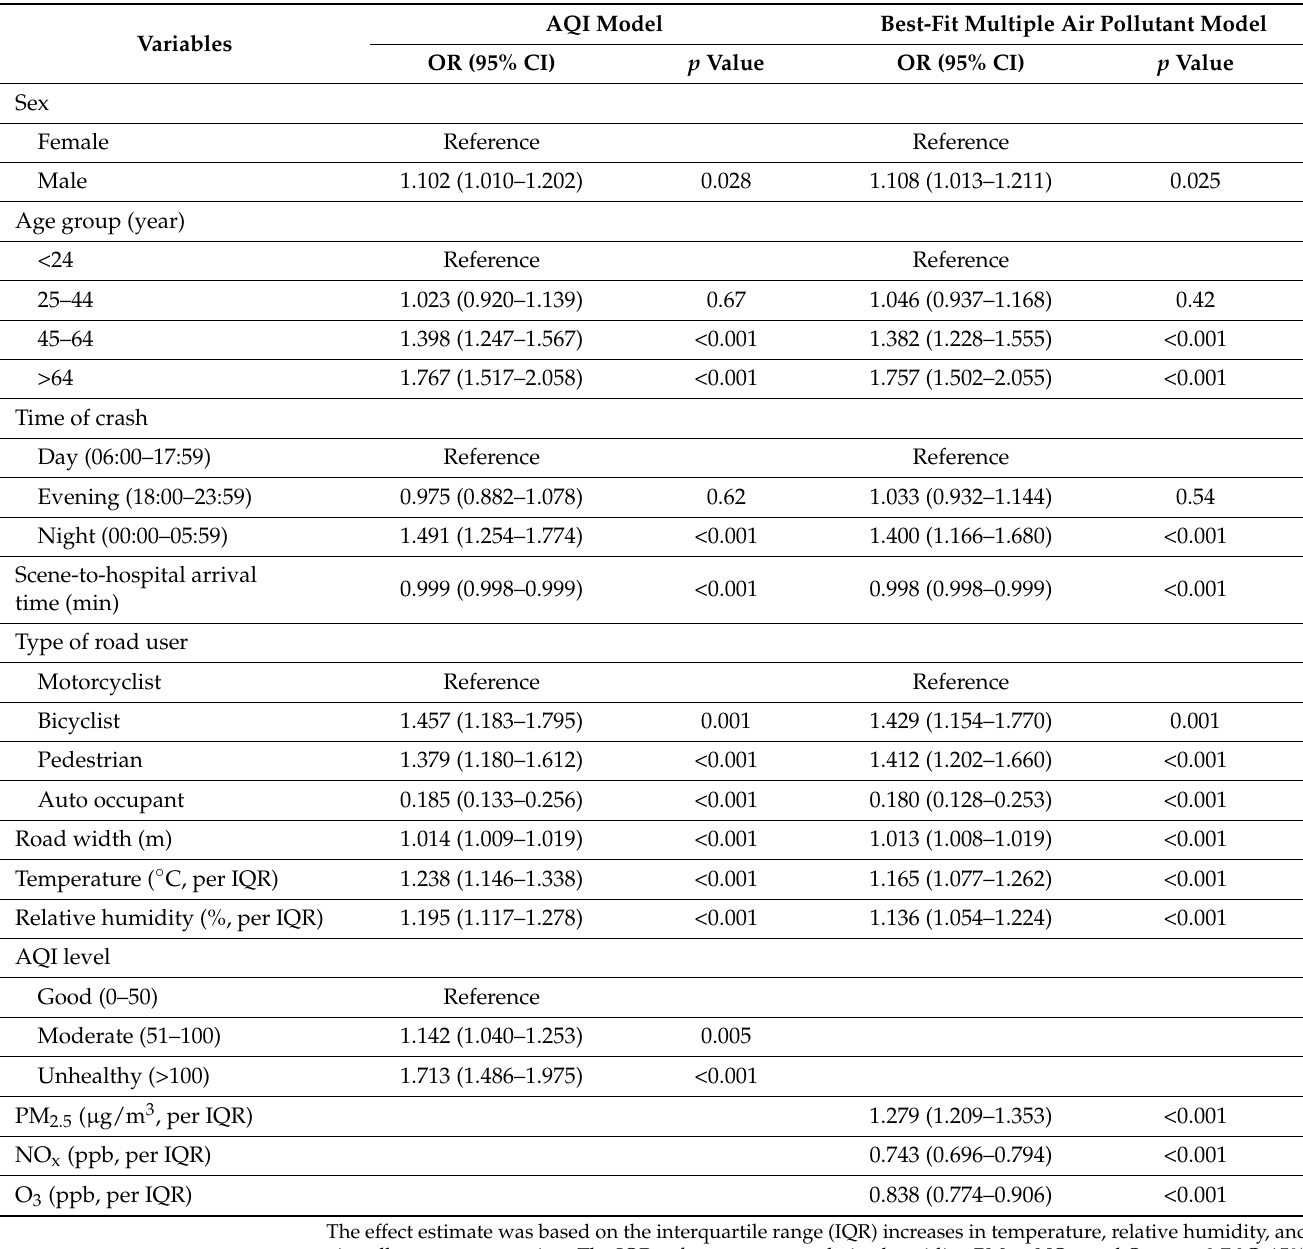
Table 2. Results of multiple regression analysis of risk factors and ISS ≥